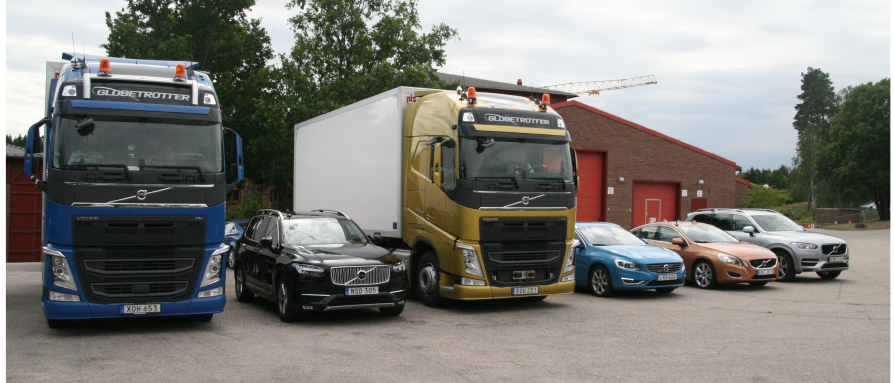
Figure 3. The six vehicles used during the measurements, from the left: Truck Blue, XC90 Black (large SUV), Truck Gold, S60 (mid size sedan), V60 (mid size wagon), and XC90